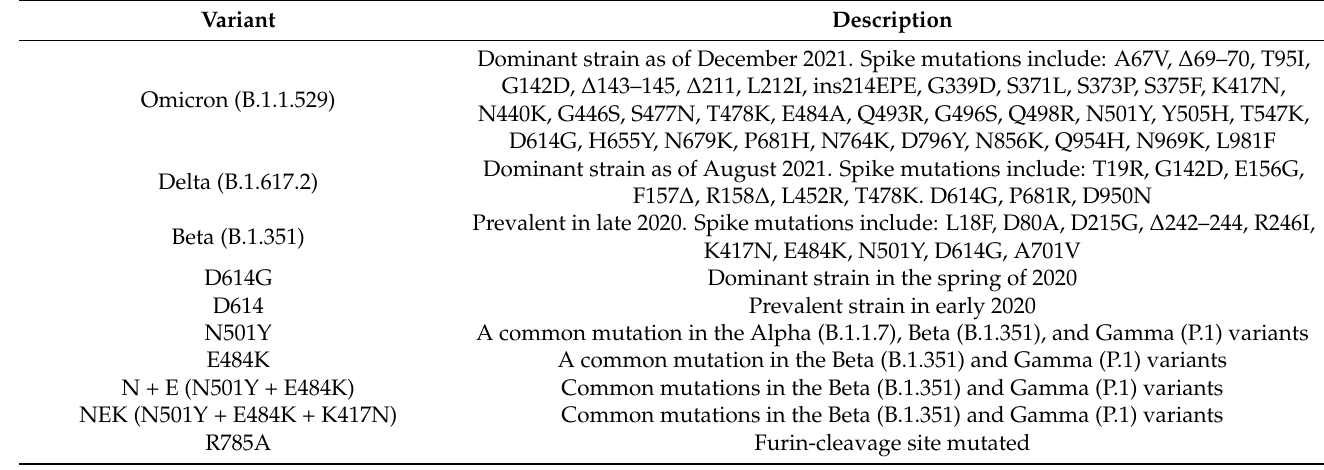
Table 1. Description of several SARS-CoV-2 viral spike variants that are represented in this study with experimental